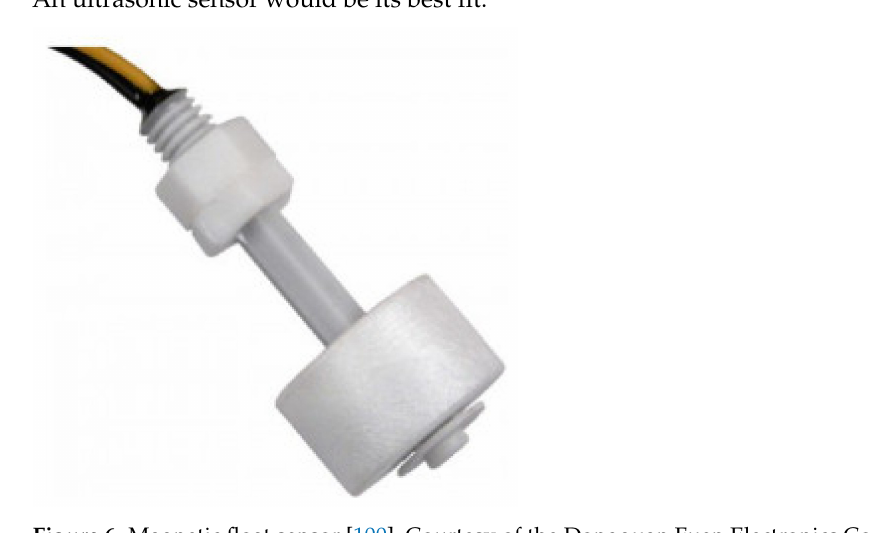
Figure 6. Magnetic float sensor [100], Courtesy of the Dongguan Fuen Electronics Co., Ltd.,